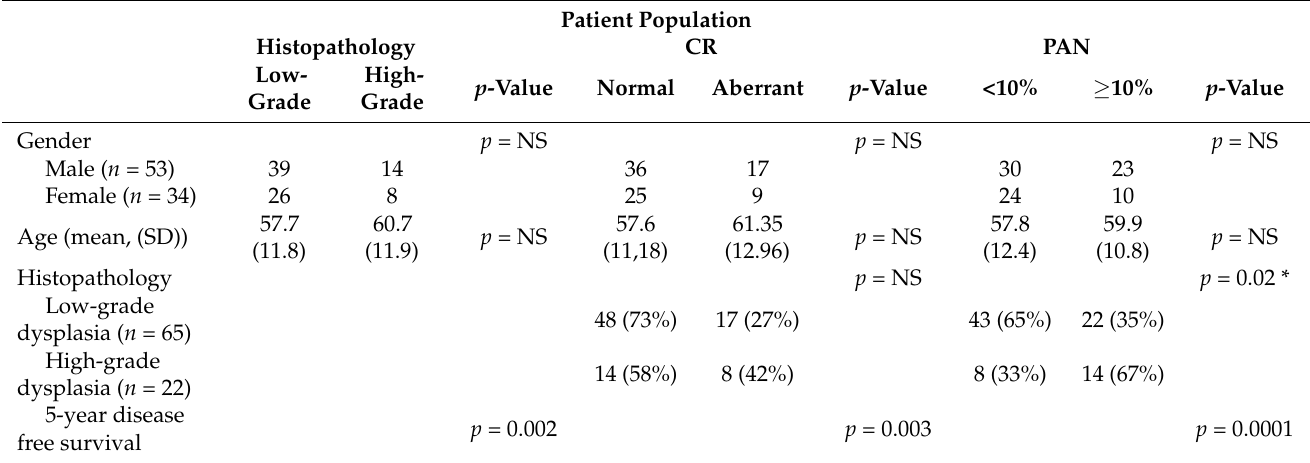
Table 2. Clinicopathological characteristics of the patient